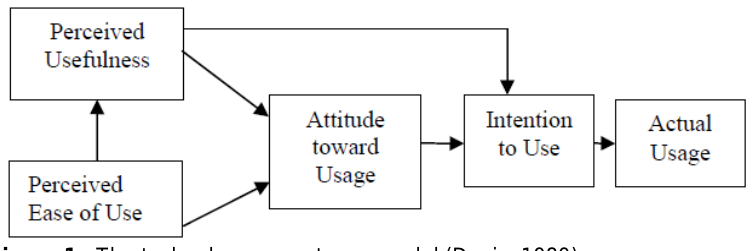
Figure 1 The technology acceptance model (Davis, 1989)